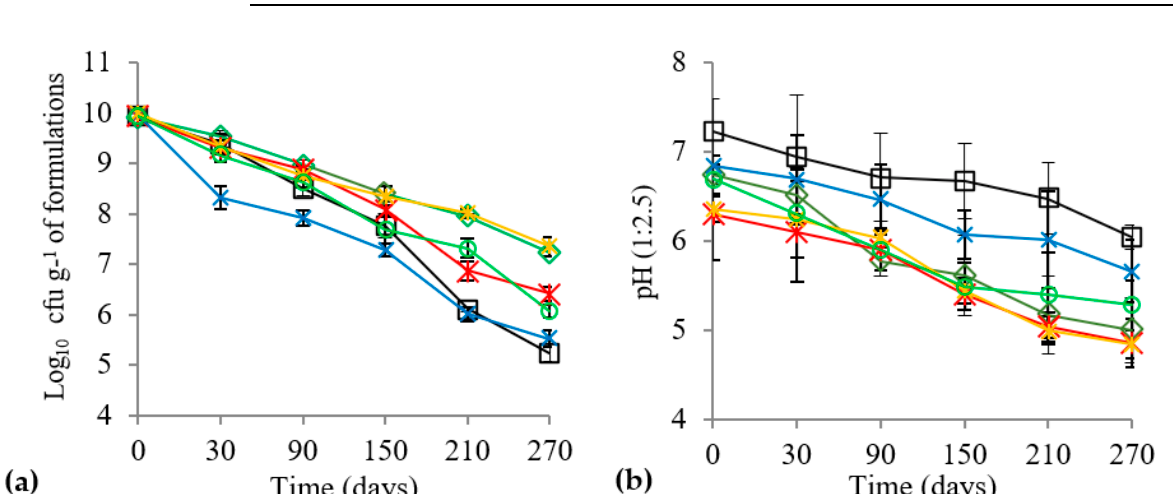
Figure 1. Changes in ( a ) logarithmic value of CFU g − 1 determined by plate-count method, ( b ) pH, and ( c ) moisture content of three biofertilizers (carrier with strain L2 and A30) during the different storage period. Mean ± SE ( n = 3). FA: flyash; BC: biochar. 3.2. Biometric Growth Parameters Effects on seed germination: Seeds treated with biofertilizer demonstrated significantly ( p < 0.05) increased rate and percent of germinations compared to untreated control seeds (Table 3). Treatment L2 + FA + BC outperformed amongst other treatments and showed a maximum increase (17.65%) in seed germination over control, whereas L2 + BC showed the maximum rate of seed germination followed by L2 + FA + BC. Table 3. Seed germination details of eggplant treated with different treatments. (Mean ± SD) Treatments